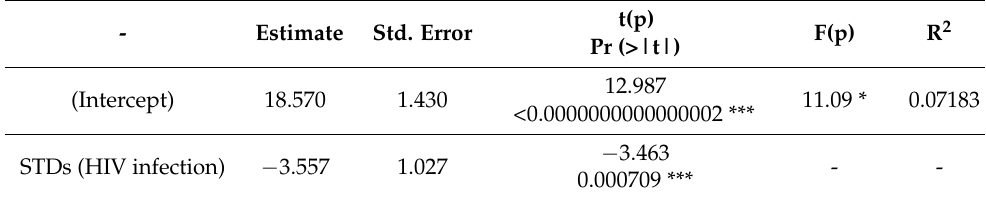
Table 15. Regression between STDs (HIV infection) and density of medical doctors.